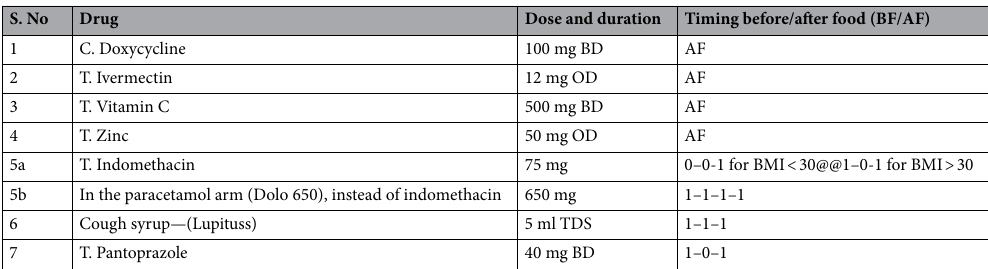
Table 1. Drug chart. T: Tablet; C: